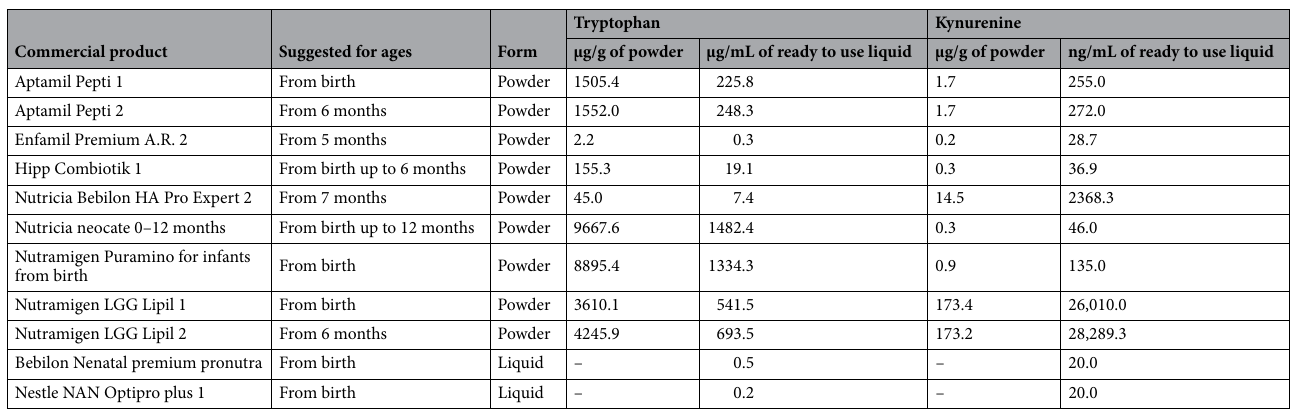
Table 1. Content of tryptophan and kynurenine in baby formulas. Liquid ready to use was prepared according to recommendation of producer. Data are presented as a mean value of 3 repetitions. Standard deviation was below 5% for kynurenine and below 6.5% for tryptophan.